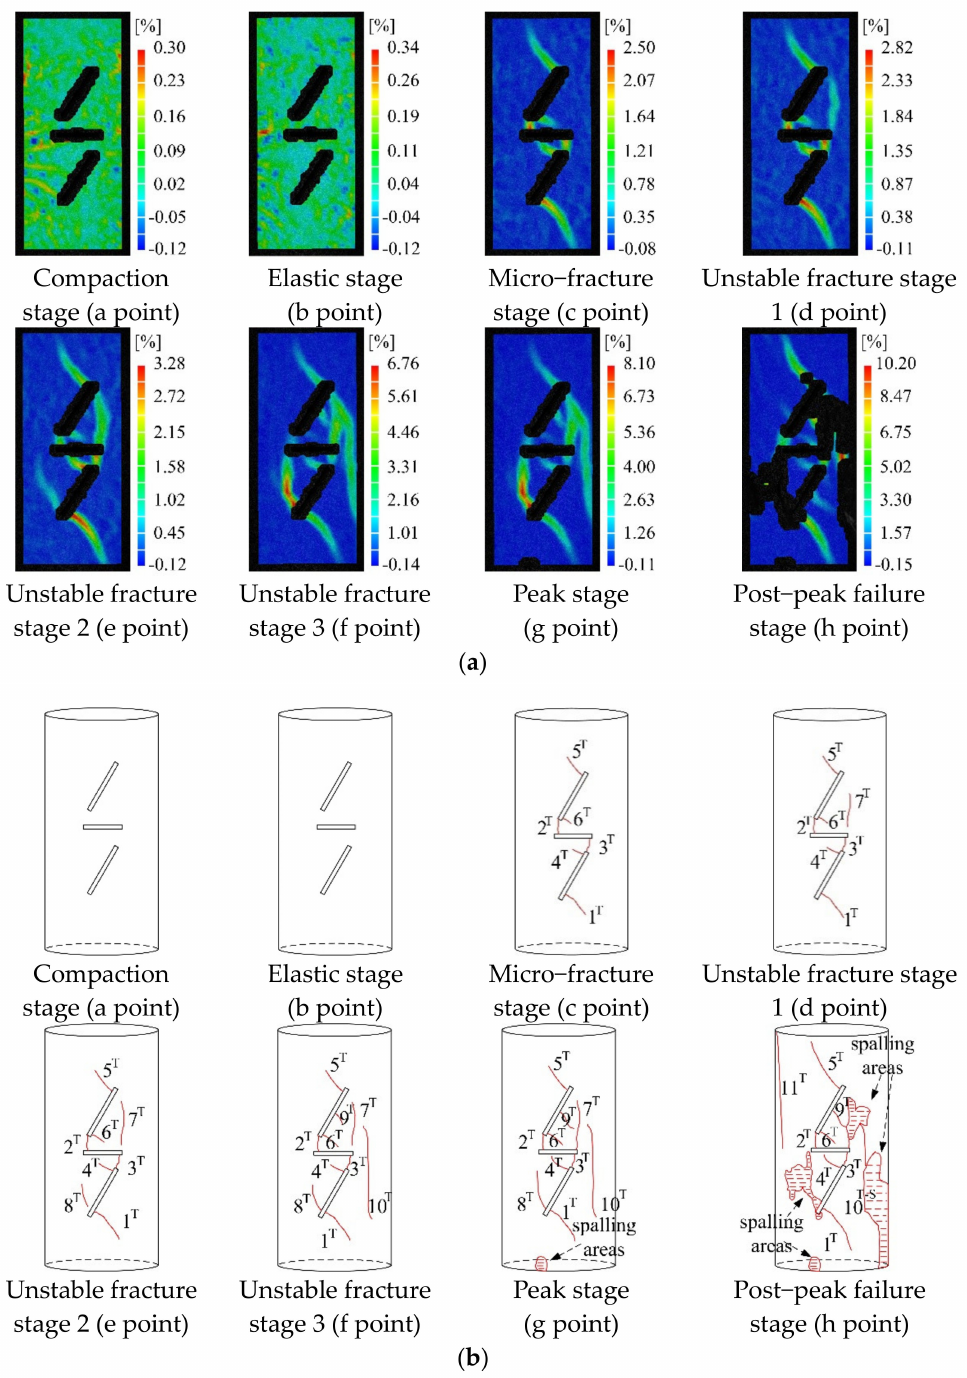
Figure 8. Principal strain nephogram and schematic diagram of crack propagation on the surface of P − 60 − 2: ( a ) principal strain nephogram; ( b ) schematic diagram of crack propagation on the surface. As shown in Figure 8, the limestone specimen with the parallel cracks of 60 ◦ also has no strain concentration in its principal strain nephogram and no crack on its surface at the compaction and elastic stages. During the stable micro-fracture development stage, obvious strain concentration areas appear under the left end of crack 2 (cid:13) , between the left end of crack 1 (cid:13) and the left end of crack 3 (cid:13) , between the right end of crack 2 (cid:13) and the right end of crack 3 (cid:13) , upper left of the right end of crack 2 (cid:13) , lower right of the left end of crack 1 (cid:13) , and above the right end of crack 1 (cid:13) . The maximum strain values in these areas are